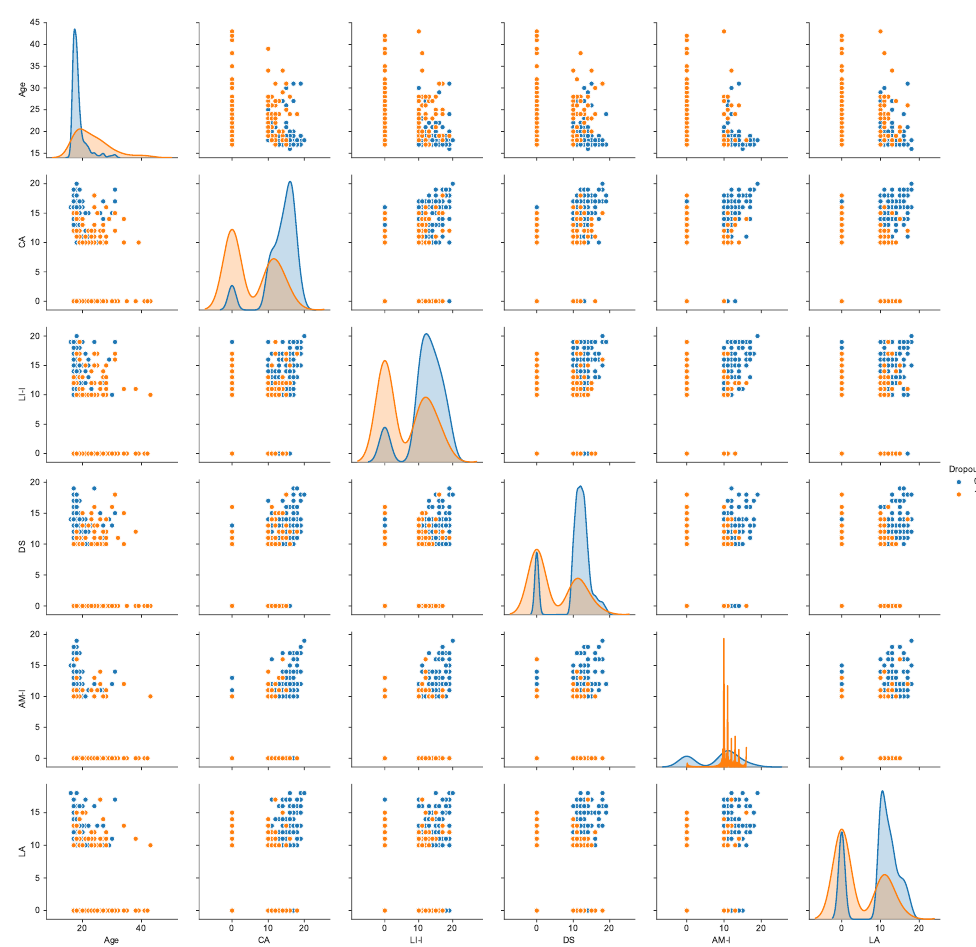
Figure 1. Pairwise relationships between the most important features {0-Success,